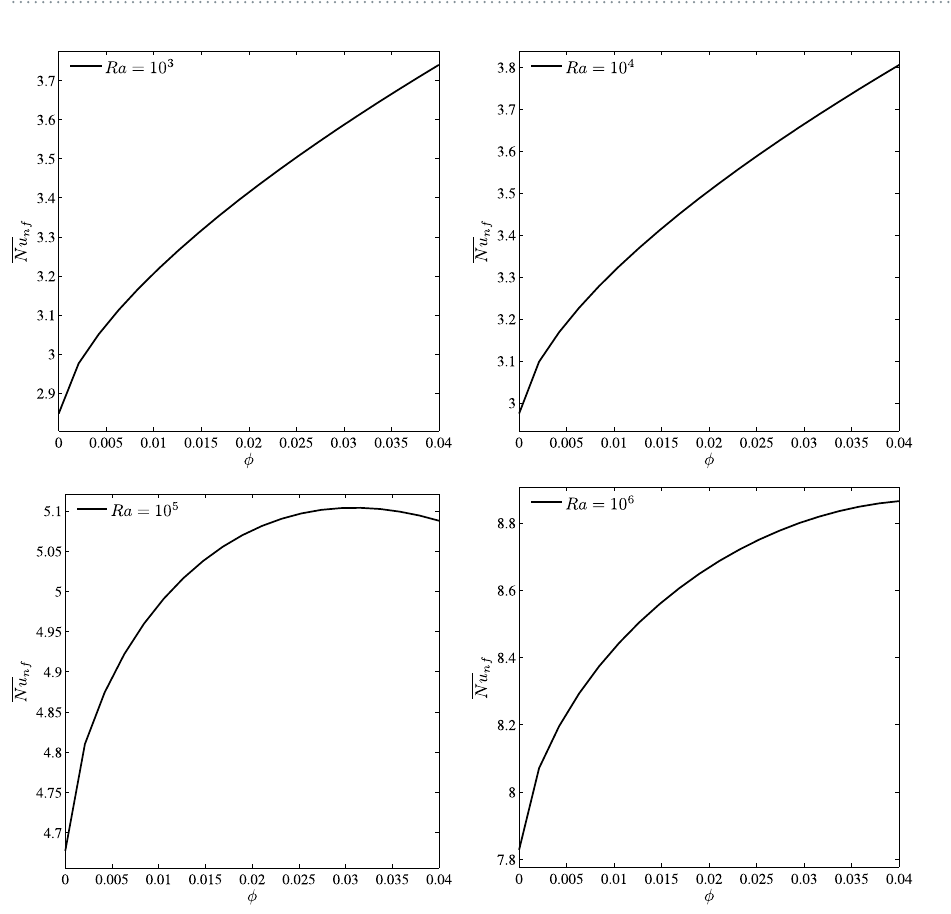
Figure 9. Variation of average Nusselt number with φ for different Ra at Ha = 0, k w = 0.76 and D =